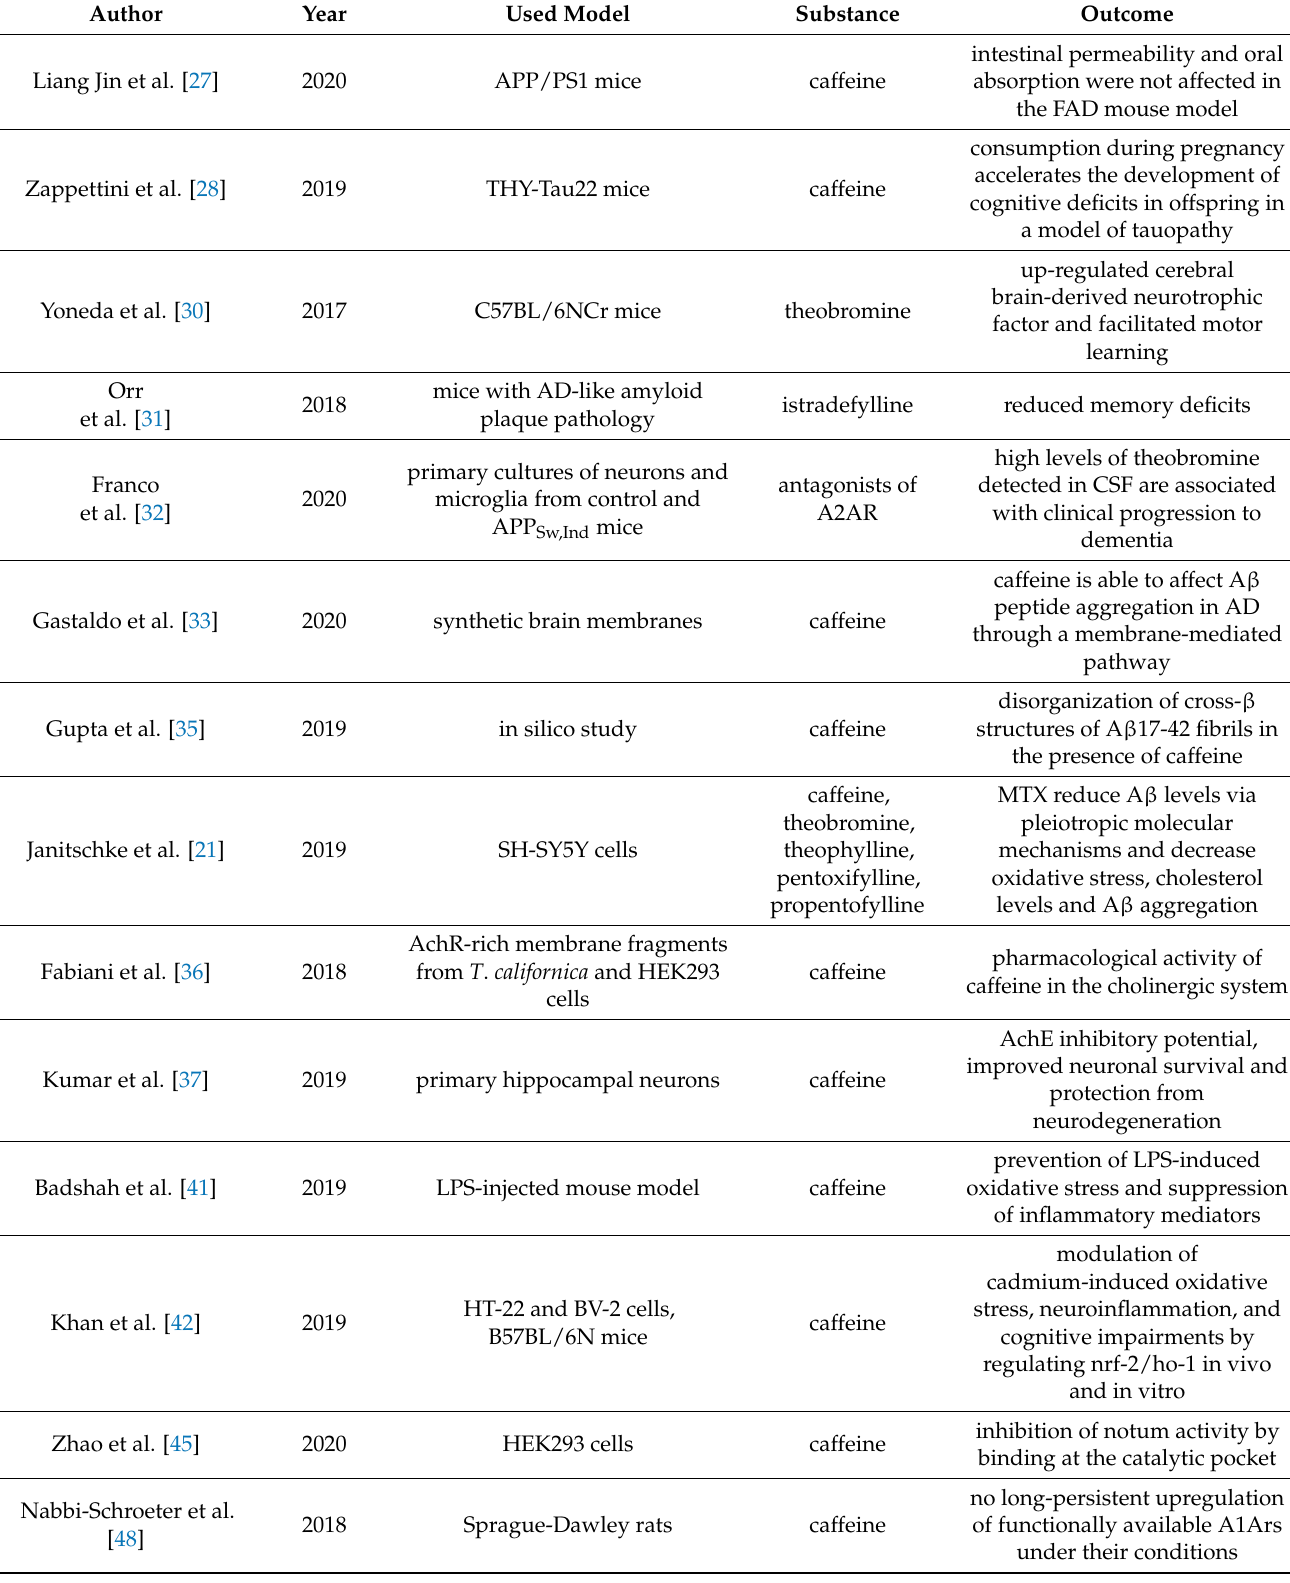
Table 2. Summary of recent animal and cell culture studies investigating the relationship between methylxanthines and Alzheimer ´ s disease (AD). FAD: familial Alzheimer ´ s disease. A1AR: adenosine A1 receptor. A2AR: adenosine A2 receptor. LPS: